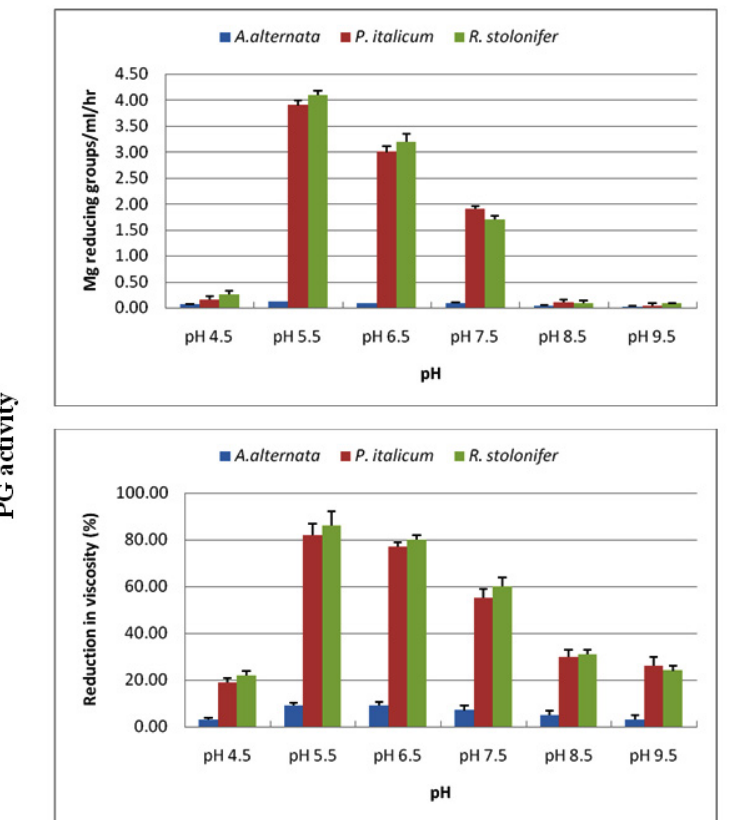
Fig. 6. Effect of incubation pH on production of PG using Czapek Dox medium amended with Pectin as carbon source for A. alternata , P. italicum and R. stolonifer after 8 days incubation at 28 ºC in the dark. All the data are the mean of three replications and Bar on each column represents the standard